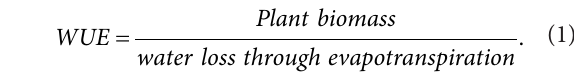
Table 2. pH, concentration of Cu, Fe, Mn (manganese), Ni, Zn, Cr (chromium) and Mg (magnesium) in groundwater, wastewater, biochar and manure